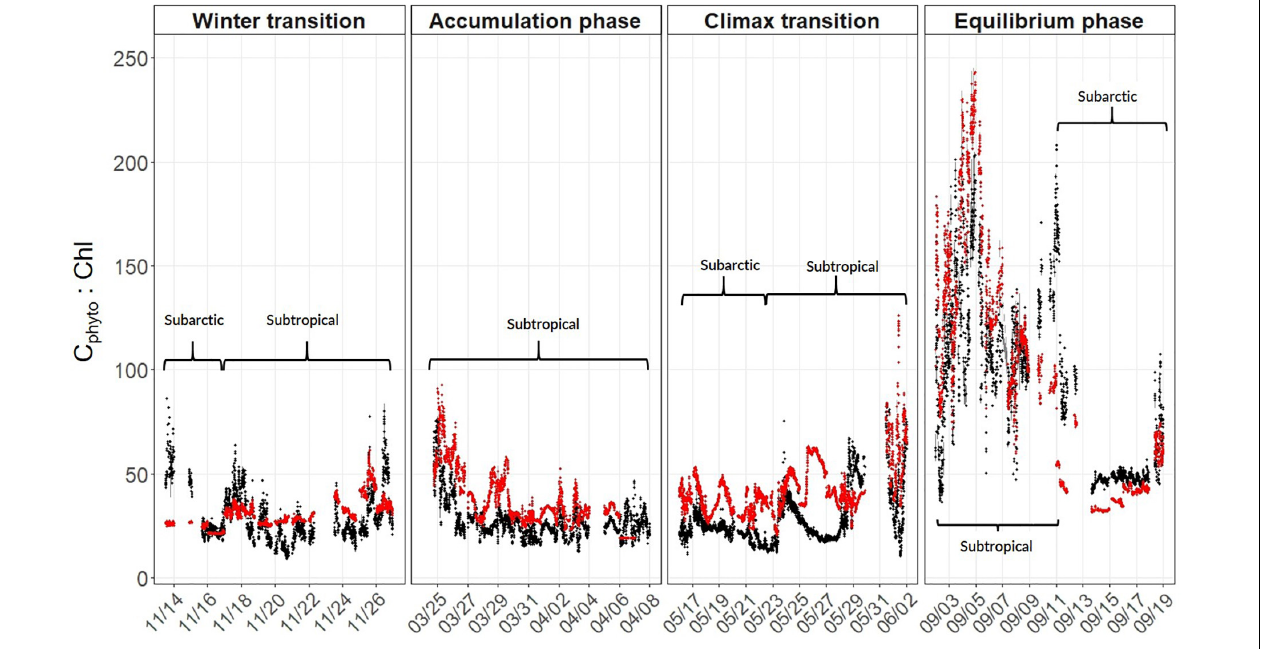
PaM, which only accounts for physiological light responses, to values (Behrenfeld et al., 2005; Graff et al., 2015; Figure 5 ). reproduce the mixed layer observations suggests that light-driven photoacclimation was the dominant driver of θ variability ( Figure 4 ). To examine secondary drivers of the remaining unexplained θ variance, we explored influences of phytoplankton community composition on particulate backscatter by comparing it against modeled estimates of carbon. Measurements of θ θ PaM and Chl ACS both correlated strongly with opt and HPLC observations, respectively ( r 2 = 0.72 and 0.95), giving confidence in the C mod values. For NAAMES, comparison of phtyo b bp ( 470 ) and C mod yielded a linear regression slope ( r 2 = 0.60, phtyo y = 14760x + 0.72) that was similar to previously published